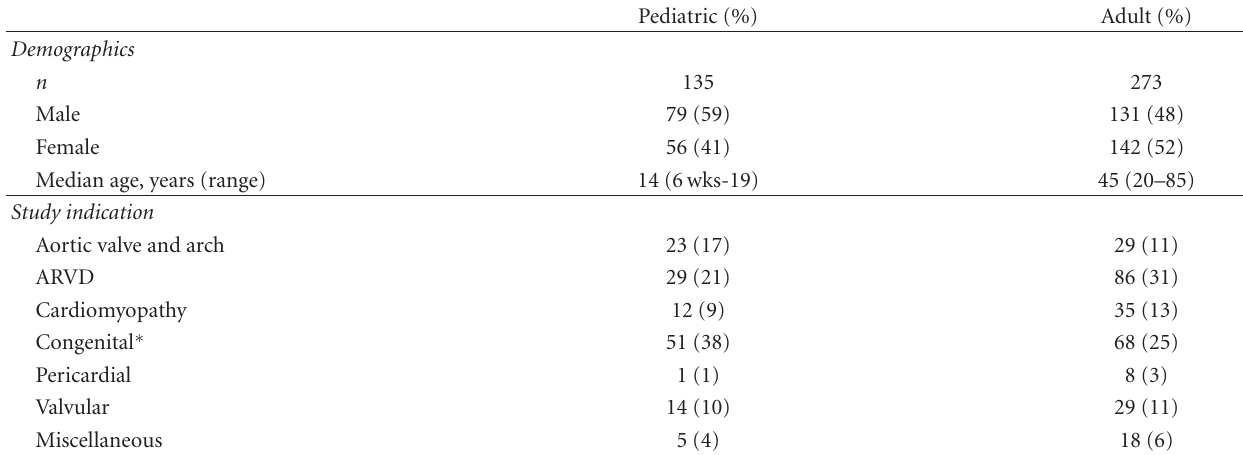
Table 1: Study population.